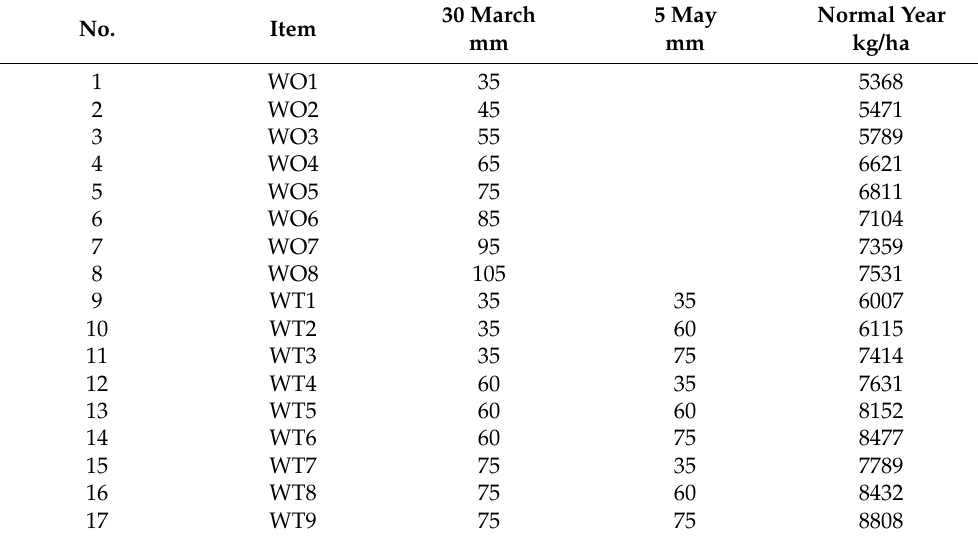
Table 9. Yield simulation of scenario A2 in the piedmont plain